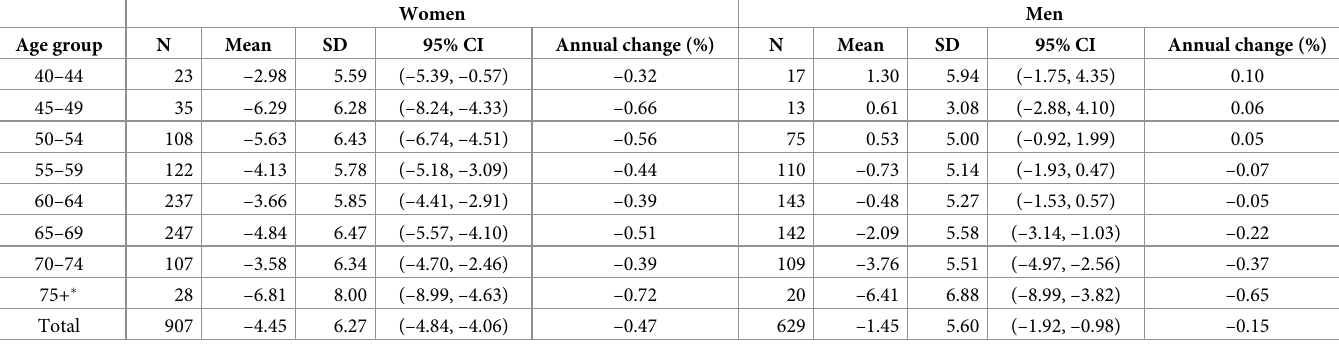
Table 4. Change per year in age-stratified left hip total bone mineral density (mg/cm 2 and percent) from Troms ø 6 to Troms ø